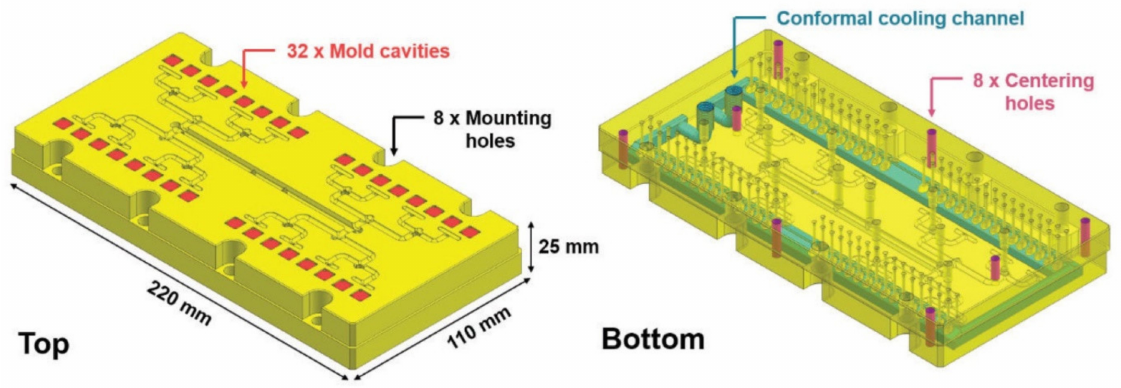
Figure 31. Original design of the injection molding insert [145].